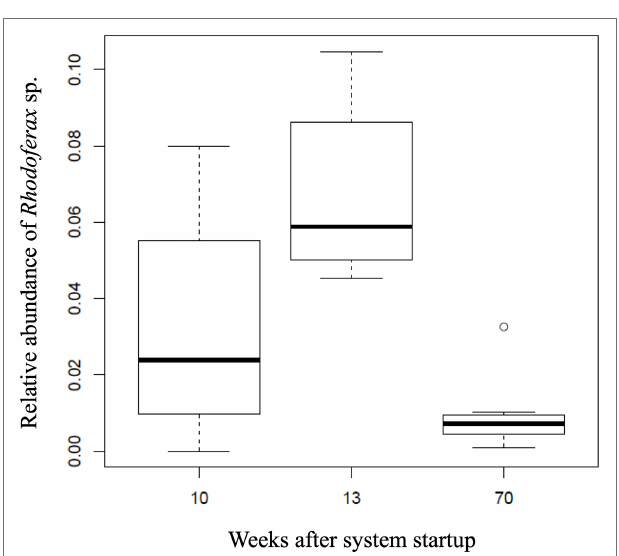
FIGURE 3 | Relative abundance of the sulfolane-assimilating Rhodoferax sp. in groundwater samples collected from the AS system after 10, 13, and 70 weeks of